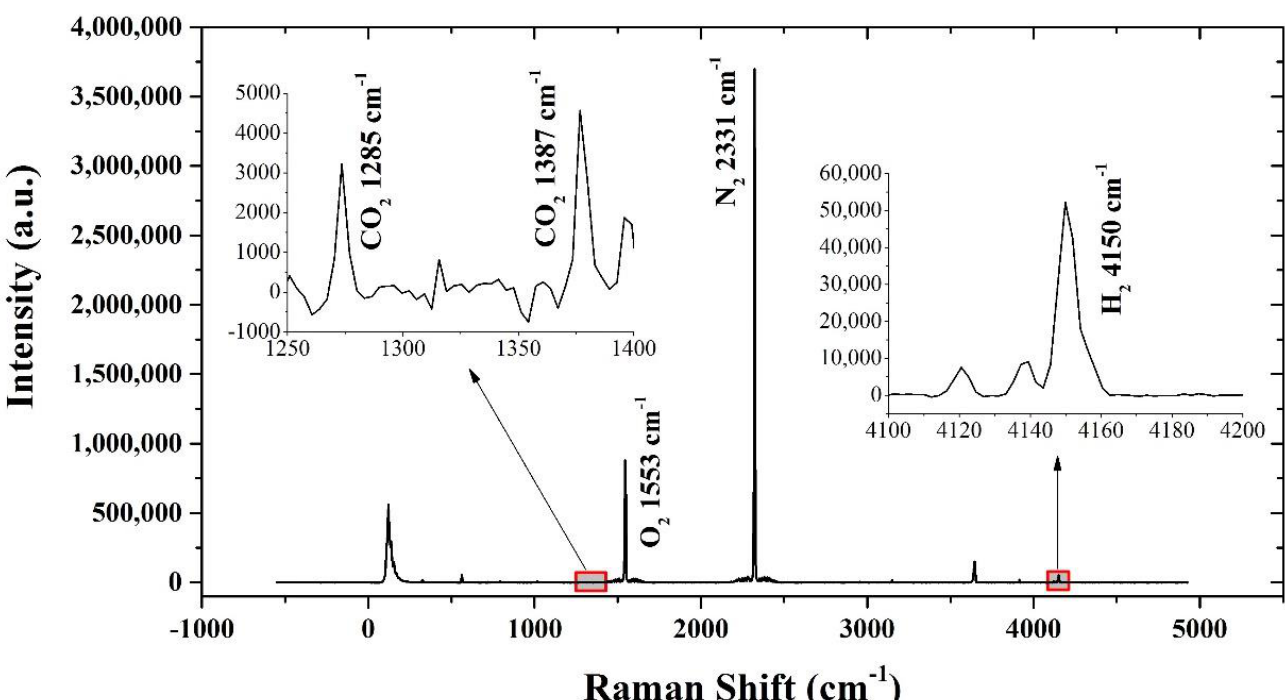
Figure 8. A typical Raman spectrum of dissolved gases in Qingdao’s offshore seawater.